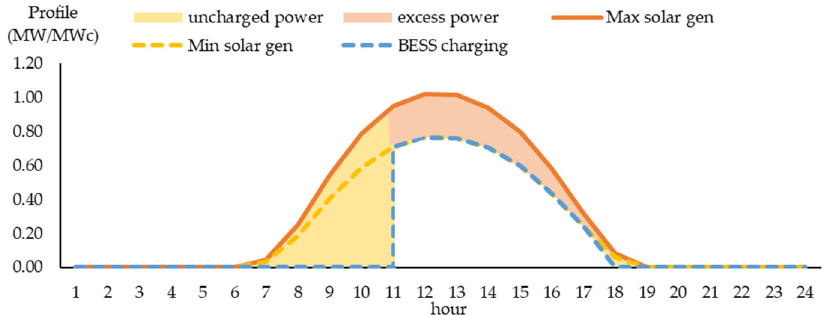
Figure 7. PVBESS profile of 1 MW contracted capacity unit.